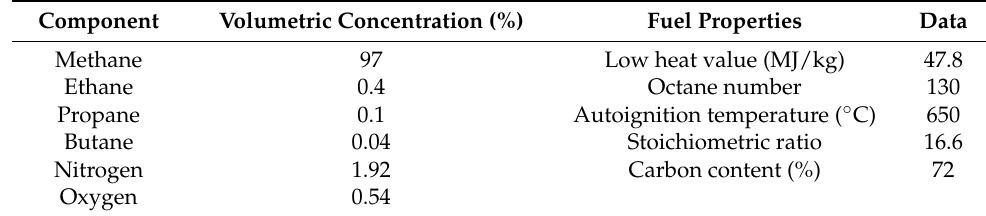
Table 2. The components and properties of the test fuel.